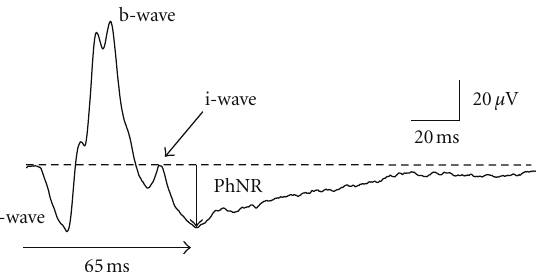
Figure 1: A representative waveform of the cone electroretinogram recoded from a normal subject by red stimuli on a blue background. PhNR: photopic negative